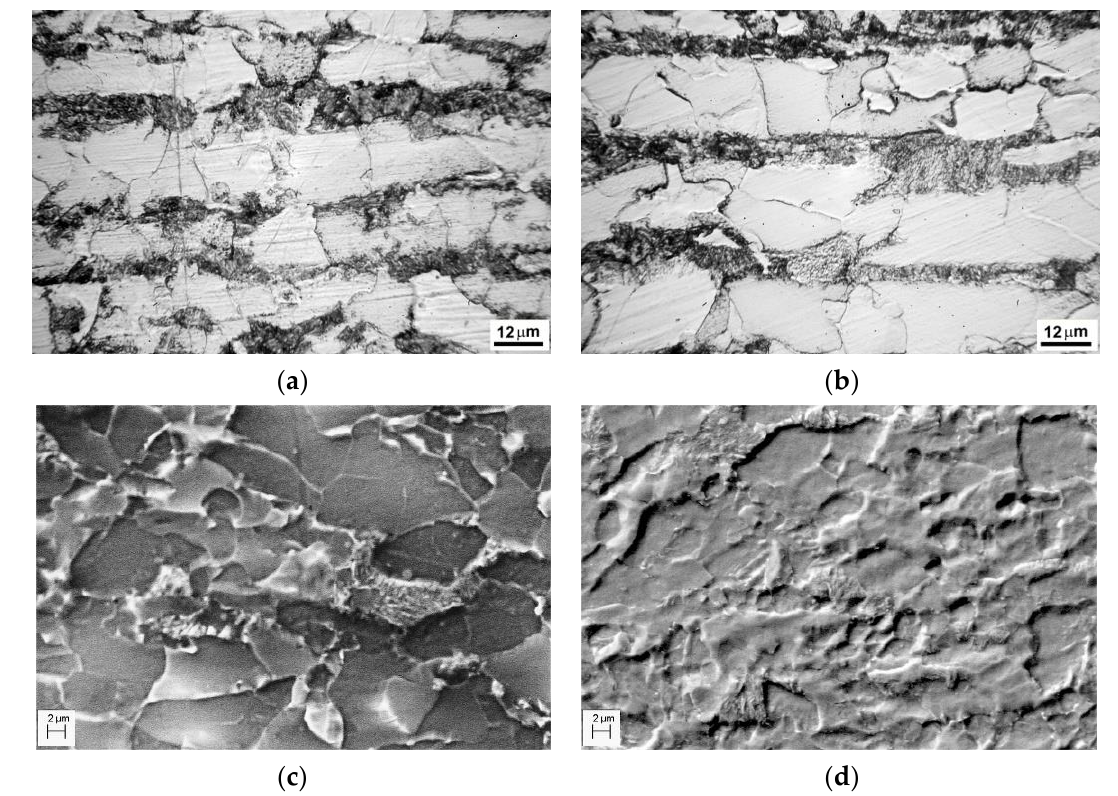
Figure 3. Microstructure of the 17H1S ( a , b ) and X70 ( c , d ) pipeline steels in the as-received state ( a , c ) and after operation for 30 ( b ) and 37 ( d ) years; at a distance of 3 mm from the outer surface of pipe in the transversal direction.